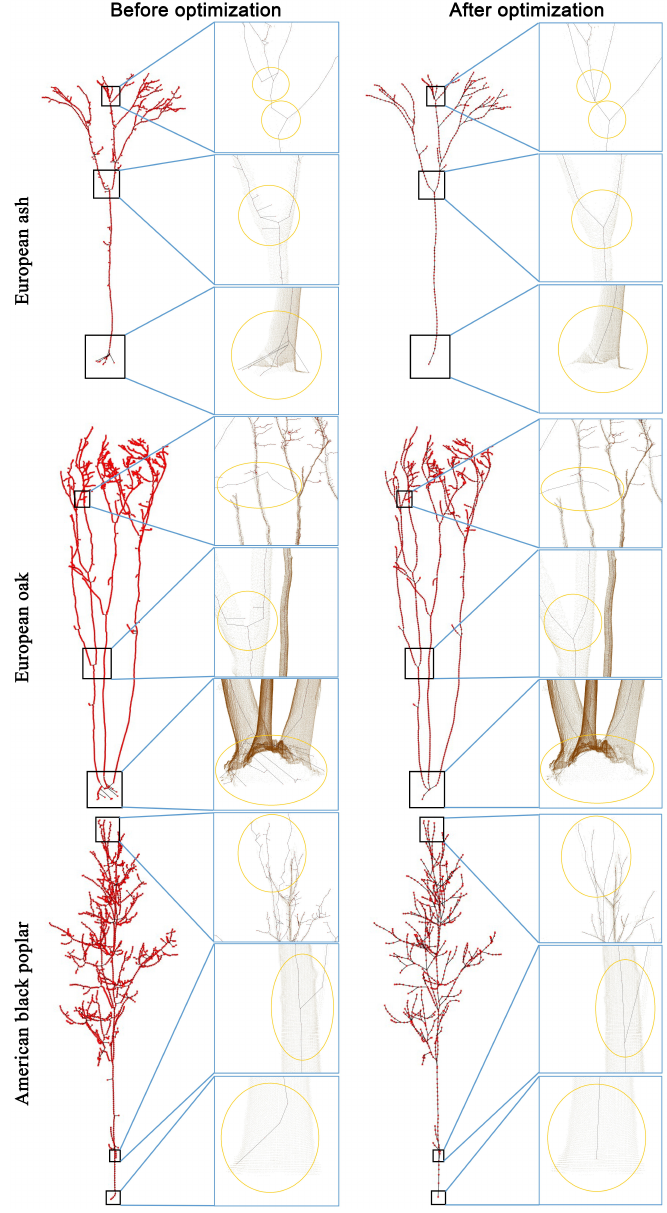
Figure 8. Comparison of skeletons before optimization and after optimization. At bifurcations, although skeletons before the optimization are corresponding to the approximate growth direction, the lines do not go through the center of the bin-s, which bring a stiff felling. The optimized skeletons in the same place are obviously close to the